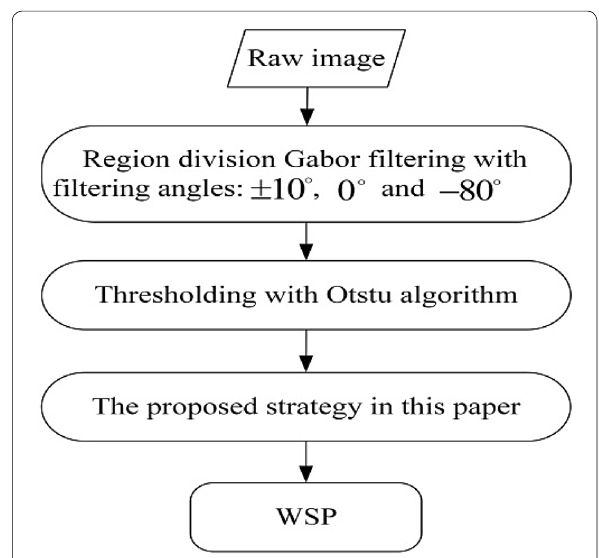
Figure 16 The second proposed flow chart with simplified preprocessing for WSPE